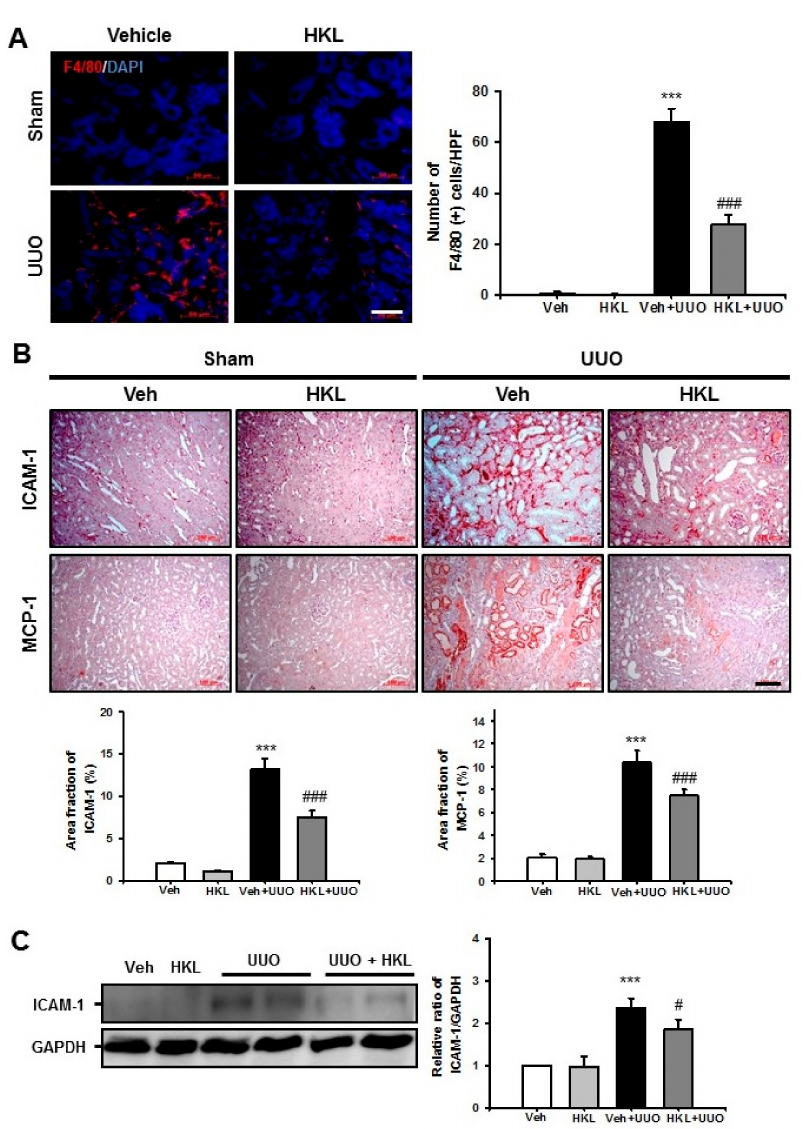
Figure 3. E ff ect of honokiol on unilateral ureteral obstruction (UUO)-induced renal inflammation. ( A ) Representative sections of kidneys from sham- and UUO-operated mice treated with vehicle (Veh) or honokiol (HKL) were immunofluorescence-stained with F4 / 80 (red). The nucleus was stained